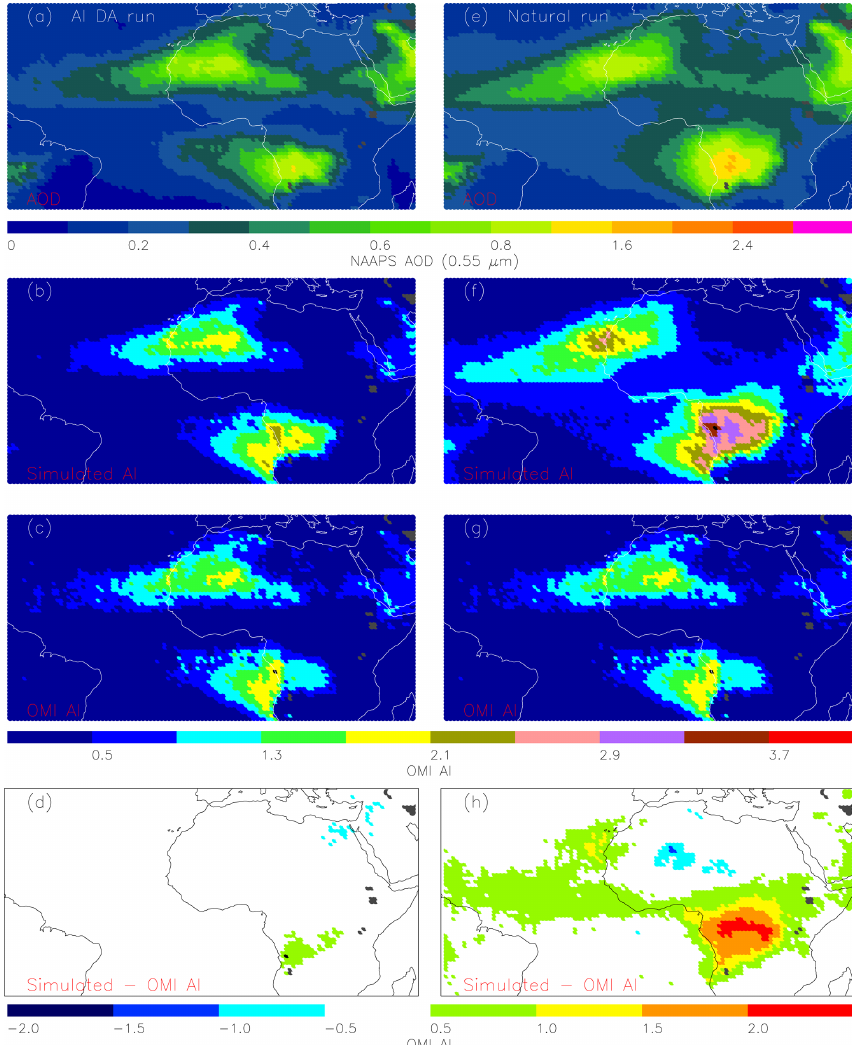
Figure 4. (a) Spatial distribution of NAAPS AOD using NAAPS data from the AI-DA runs for July and August 2007. Only NAAPS data that have collocated OMI AI data are used. (b) Spatial distribution of simulated AI for July and August 2007 using NAAPS data from the AI-DA runs. (c) Spatial distribution of gridded OMI AI for July and August 2007. (d) Differences between (b) and (c) . (e) – (h) Similar to (a) – (d) but using NAAPS natural runs. Grey highlights 1 × 1 ◦ (latitude–longitude) bins that have fewer than three collocated NAAPS and OMI AI data points for the study